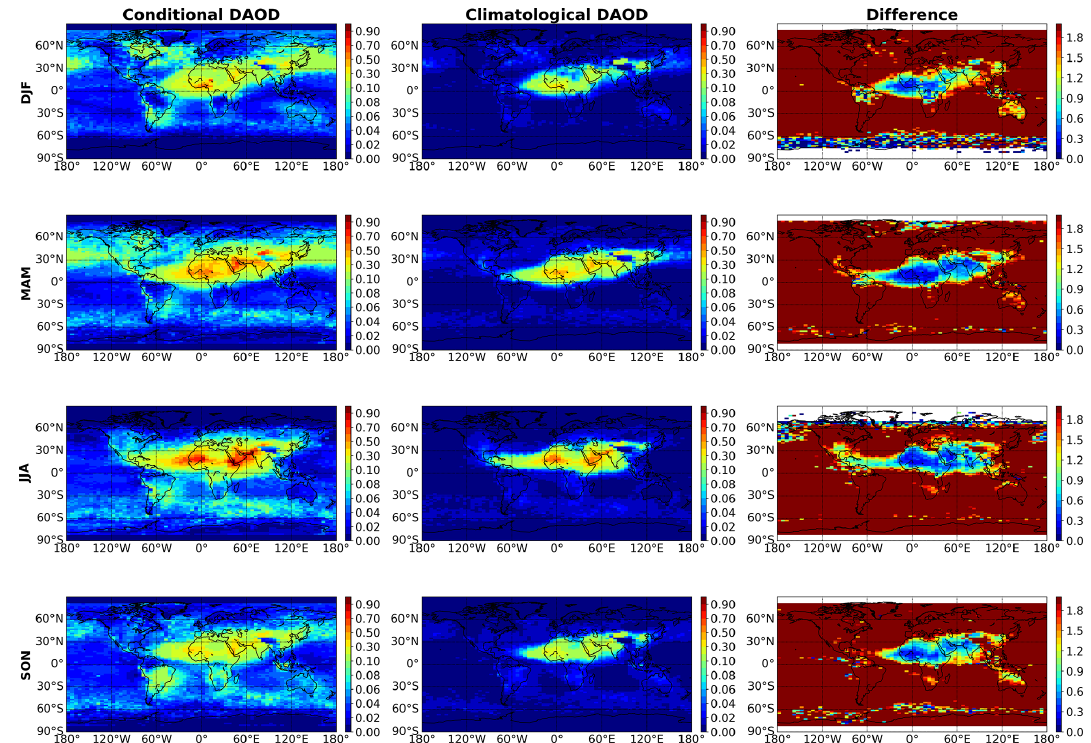
Figure 6. Conditional DAOD (the first column) and climatological DAOD (the second column) based on CALIOP dust retrieval from 2007 to 2019. The third column shows the relative difference between conditionally sampled DAOD and climatological DAOD with respect to the climatological DAOD expressed in fraction.